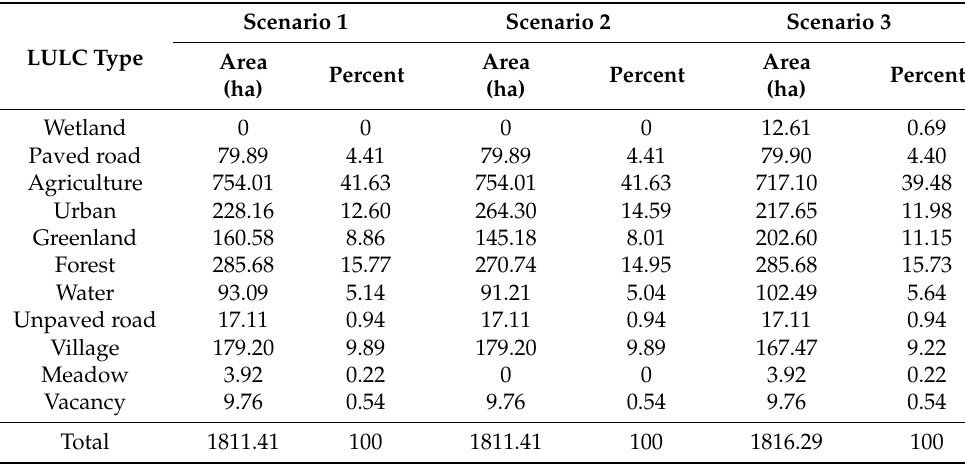
Table 3. The percentage of Luming Park about LULC data in the three scenarios.